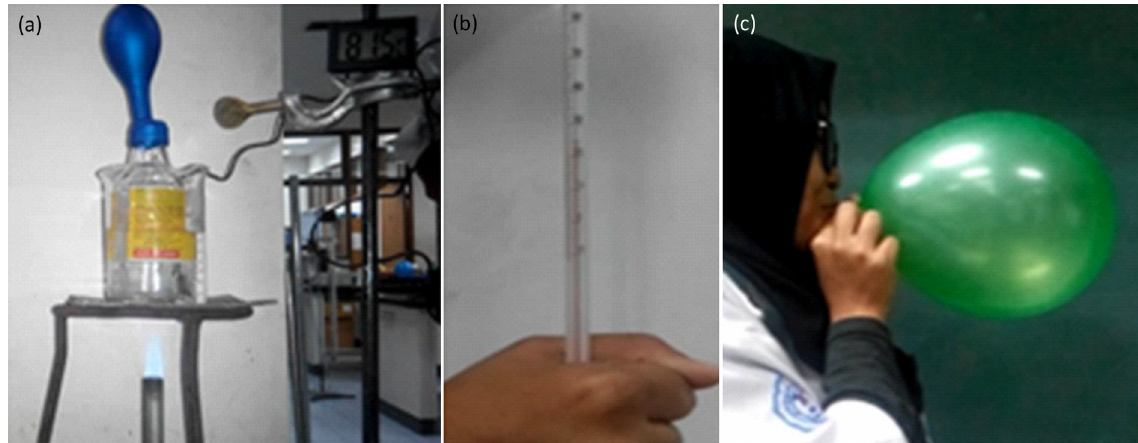
Figure 6. Demonstration activity to construct the concept of thermal expansion and temperature. (a) a balloon is being heated, (b) thermometer is held by a hand, (c) a balloon is being